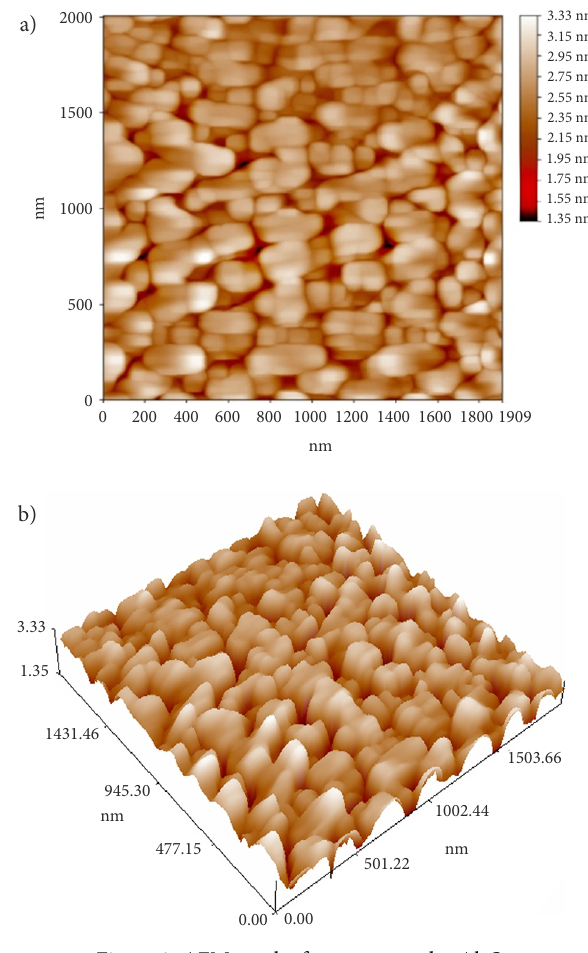
Figure 2. AFM results for nano powder Al 2 O 3